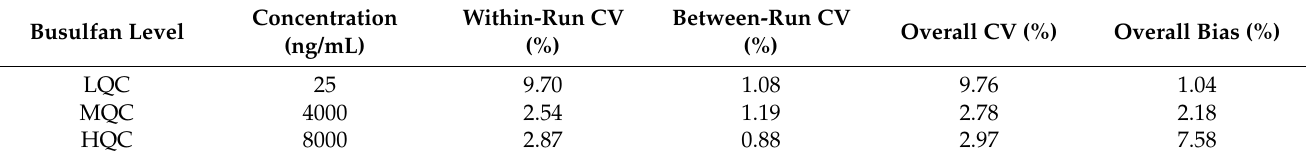
Table 2. Validation results for accuracy and precision.